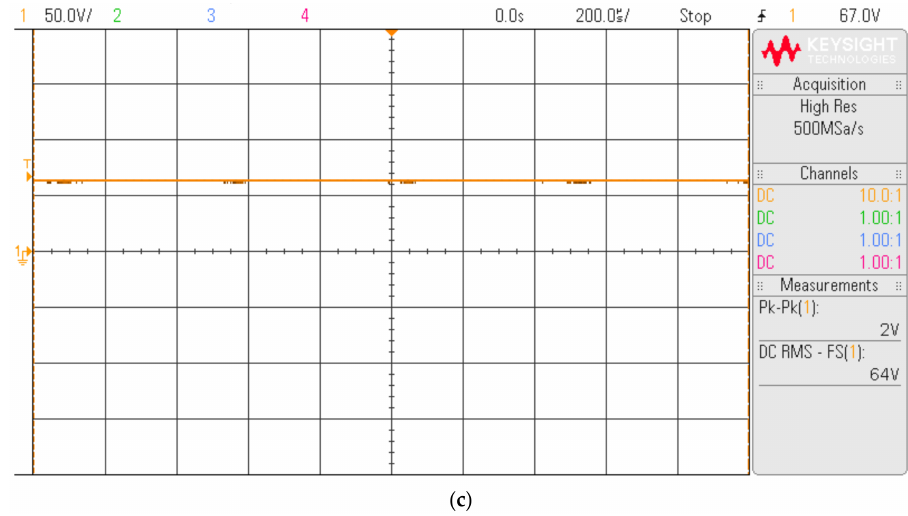
Figure 9. Output wave forms of step-up mode. ( a ) Output voltage and output current, ( b ) voltage across inductors (I L1 and I L2 ), and ( c ) capacitor voltage (V C1